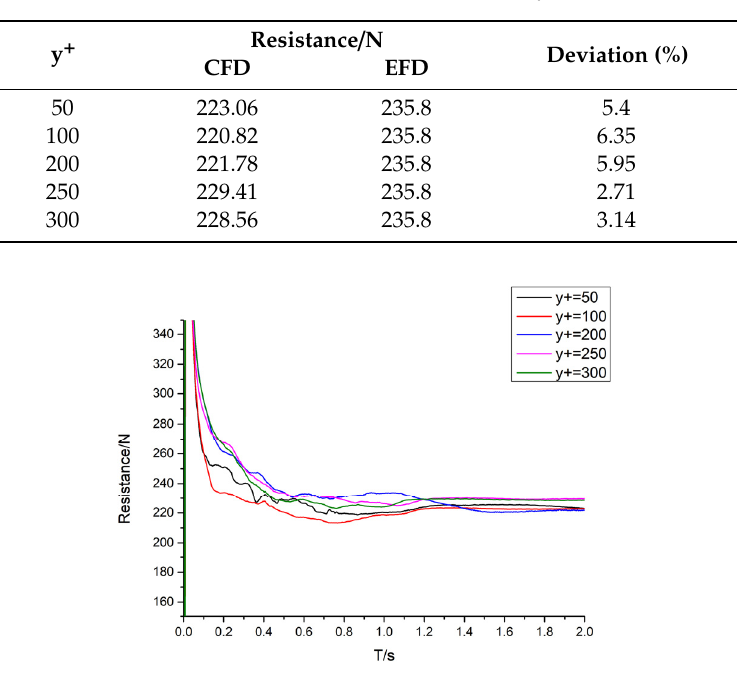
Table 6. Numerical results of different y+.